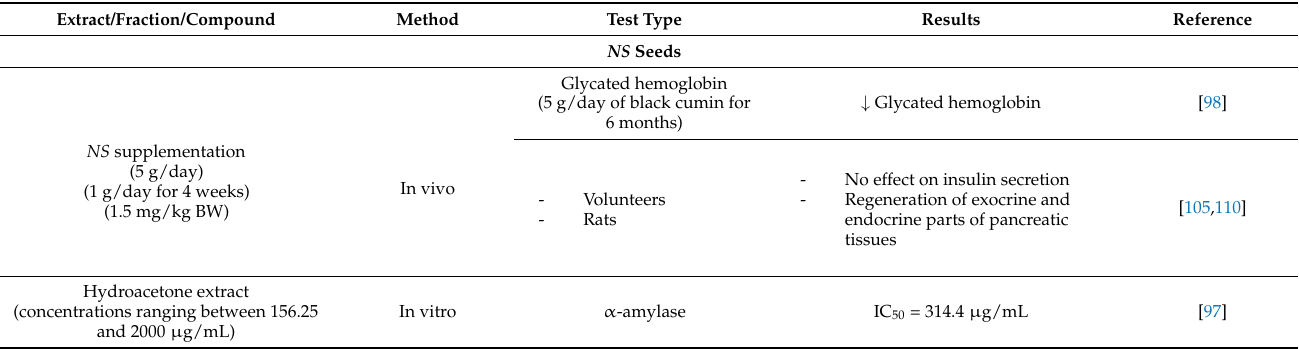
Table 6. Summary of the antidiabetic activities of